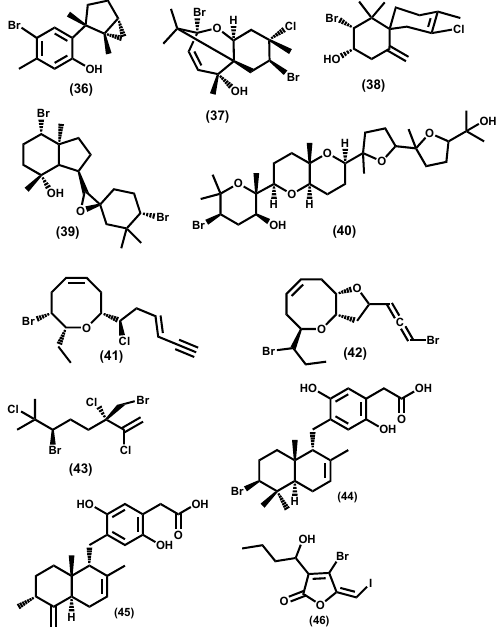
Figure 6. Chemical structure of secondary metabolites from red algae.